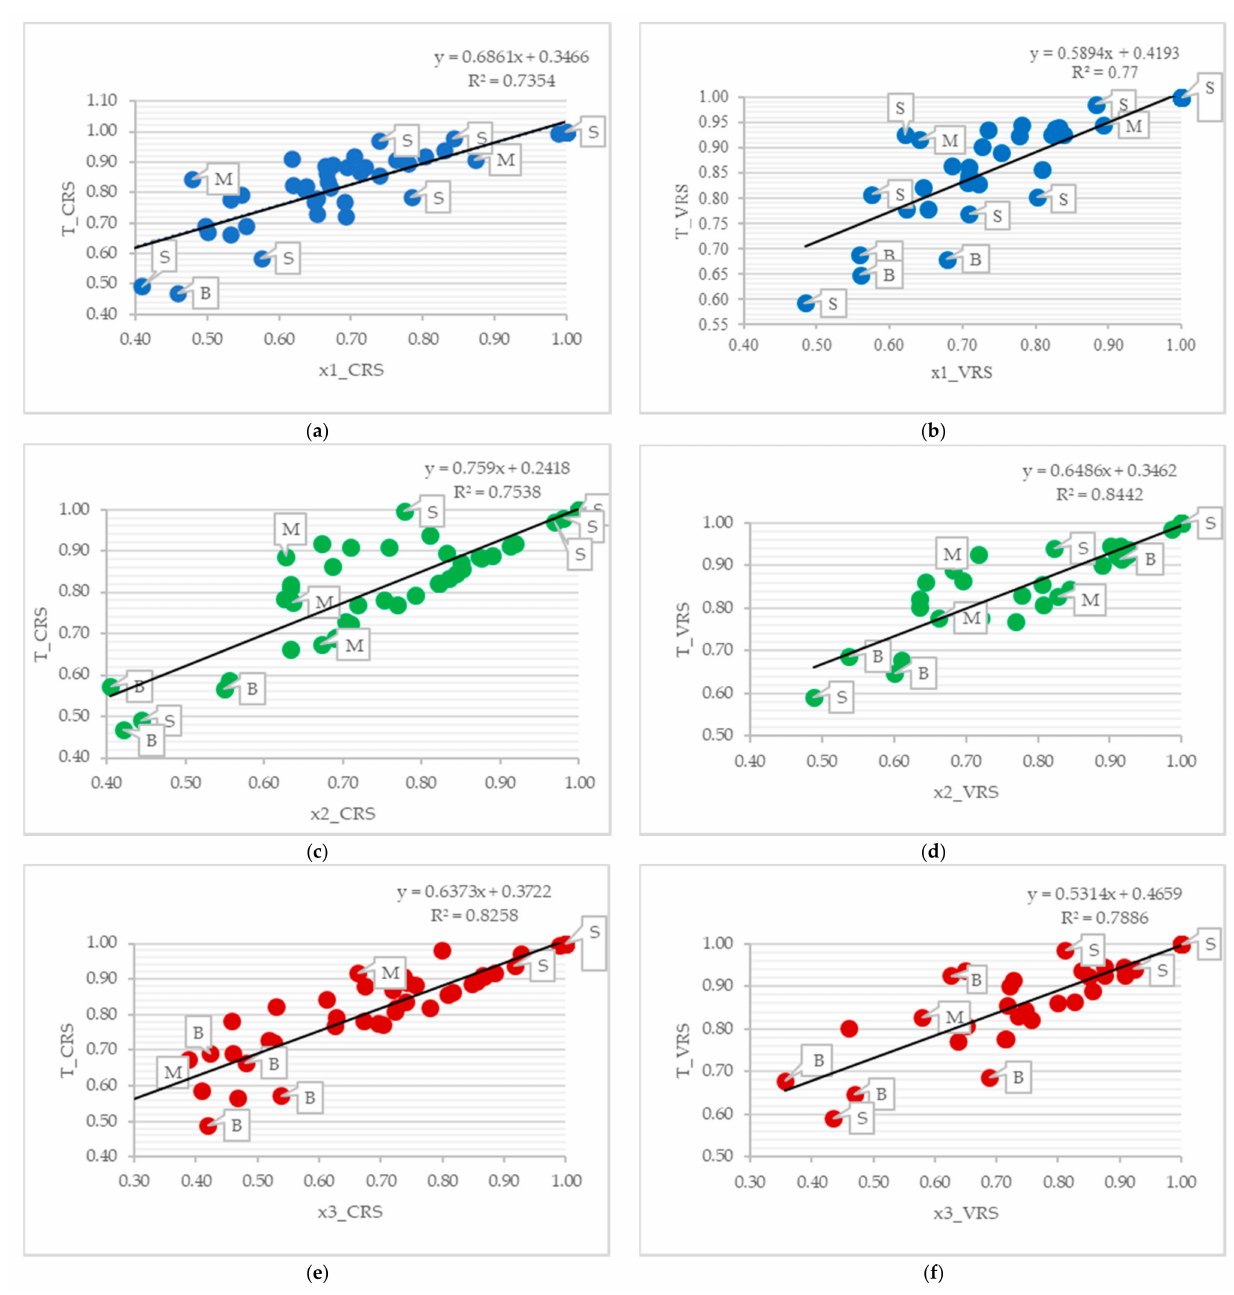
Figure 2. Results within the regression analysis context. ( a ) Regression line T_CRS and x1_CRS. ( b ) Regression line T_VRS and x1_VRS. ( c ) Regression line T_CRS and x2_CRS. ( d ) Regression line T_VRS and x2_VRS. ( e ) Regression line T_CRS and x3_CRS. ( f ) Regression line T_VRS and x3_VRS. Note: S = Small hospitals; M = Medium hospitals; B = Big